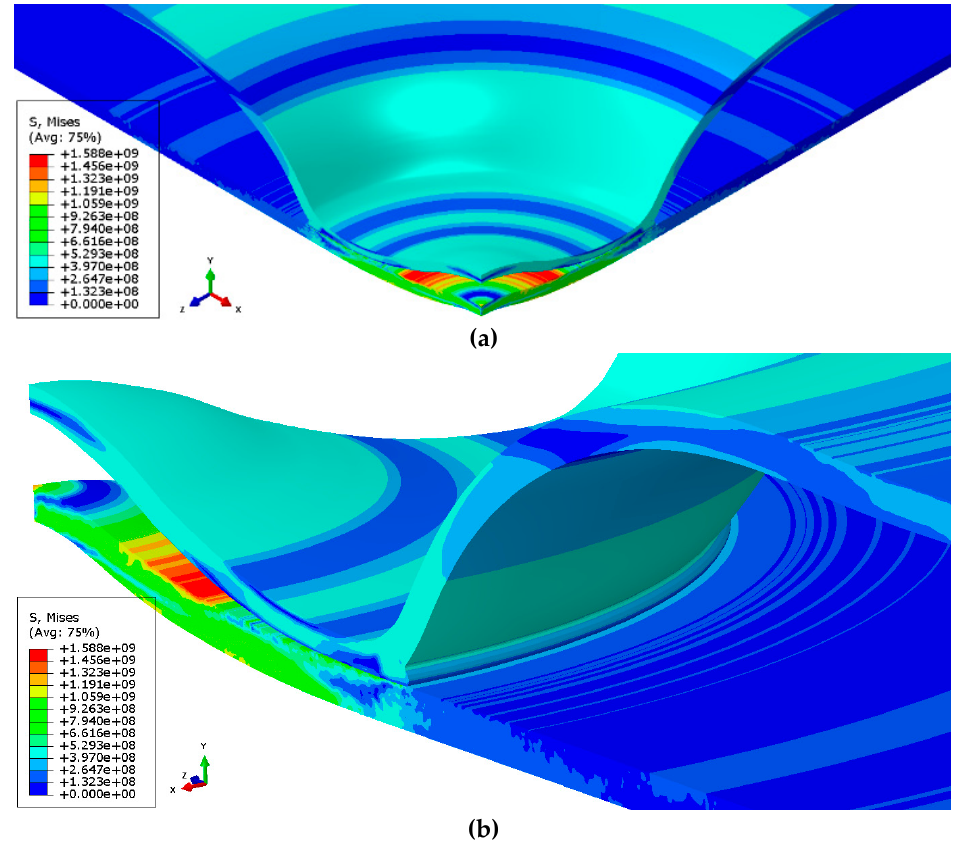
Figure 17. Resultant 3D images of the deformed foils and von Mises stress (Pa) contour plots (the axysimmetric simulation at 1 μ s): ( a ) Overview of the geometry; ( b ) Closer view of the springback.